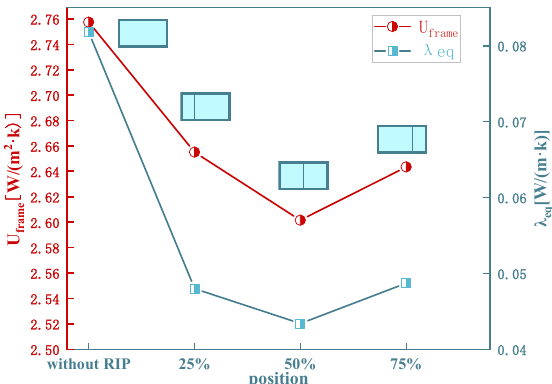
Figure 7. Effect of RIP position on heat transfer from window frame. Table 3. Effect of RIP position on heat transfer from window frame. Position